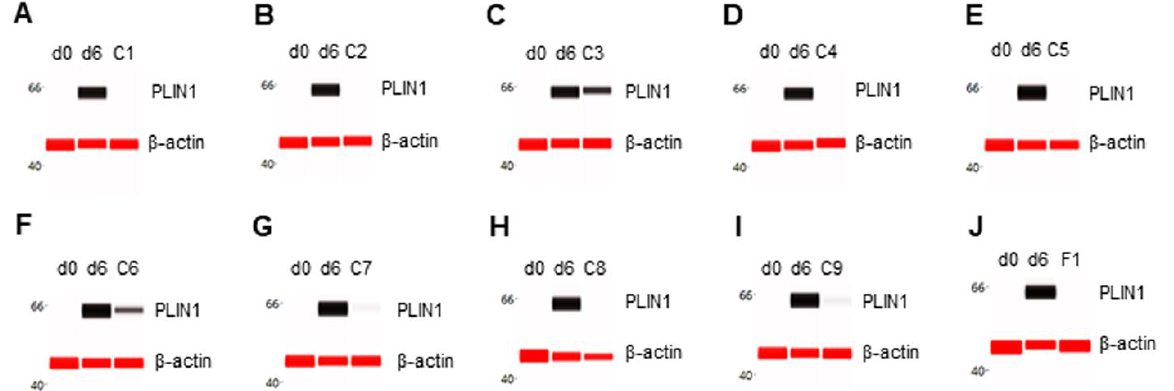
Figure 4. Suppression of PLIN1 expression in differentiating preadipocytes. Expression level of PLIN1 in preadipocytes on d0, d6 post-differentiation, or d6 post-differentiation in the presence of ( A ) berberine (C1), ( B ) luteolin (C2), ( C ) resveratrol (C3), ( D ) fisetin (C4), ( E ) quercetin (C5), ( F ) fucoidan (C6), ( G ) EGCG (C7), ( H ) hesperidin (C8), ( I ) curcumin (C9), or ( J ) F1 composition. β -actin served as a loading control. The protein expression level was measured using multiplexed capillary Western immunoassays. Molecular markers in kilodalton (kDa) are displayed on the left of the capillary Western immunoassay